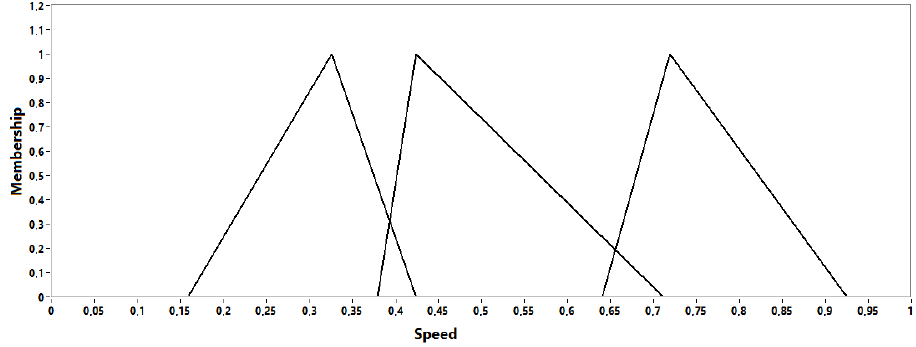
Figure 7. The sets of the speed variable; left set: slow; middle set: medium; right set: fast.